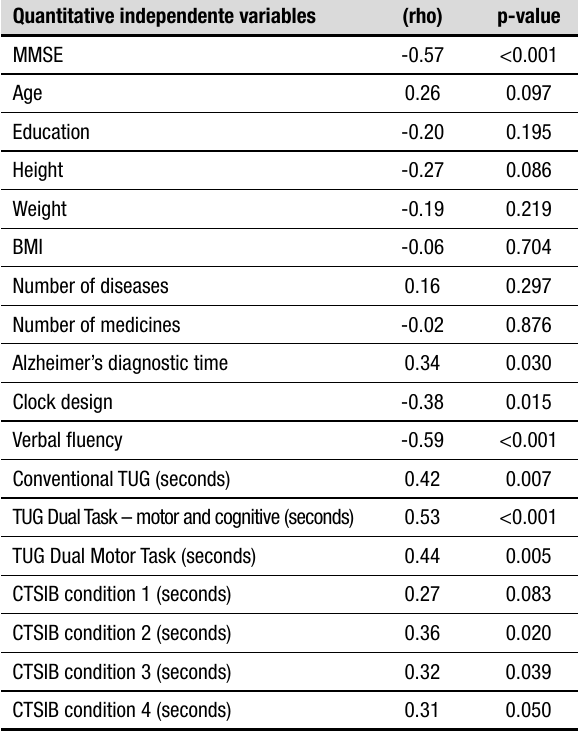
Table 3. Correlation between functional capacity and sociodemographic, anthropometric, clinical, cognitive, mobility, and postural balance variables of aged people with Alzheimer disease (n=40).